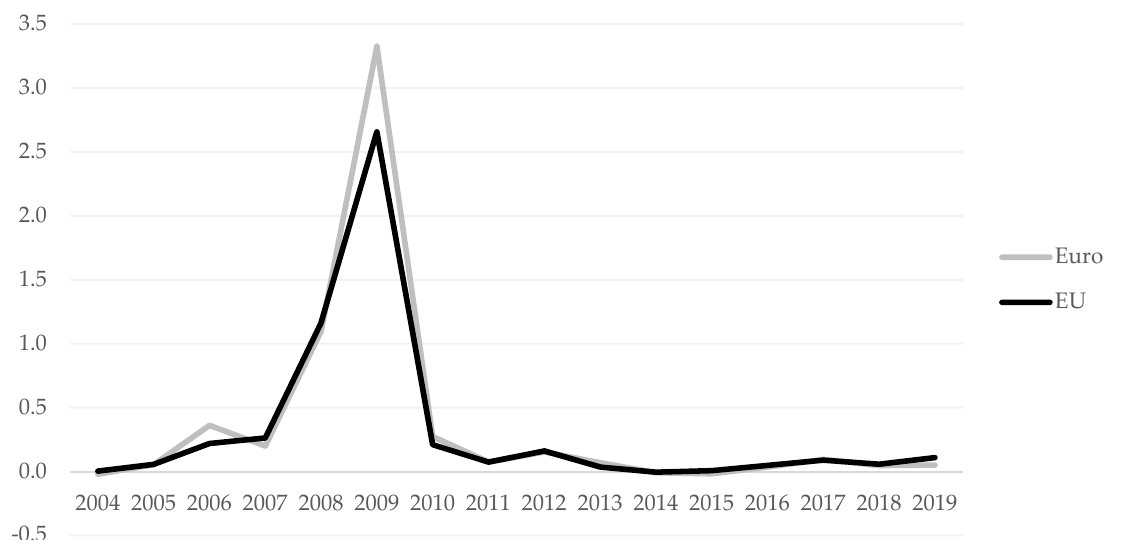
Figure 4. Business cycle synchronization (in terms of real GDP growth) measured with instantaneous quasi-correlations. Source: Own calculations, based on Macrobond.